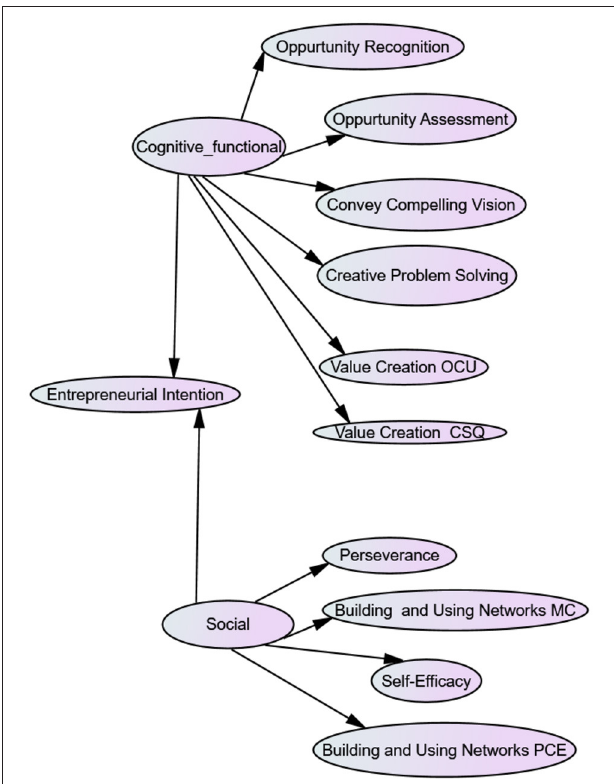
FIGURE 4 | Model representation of the tested EI-competency higher-order category model.